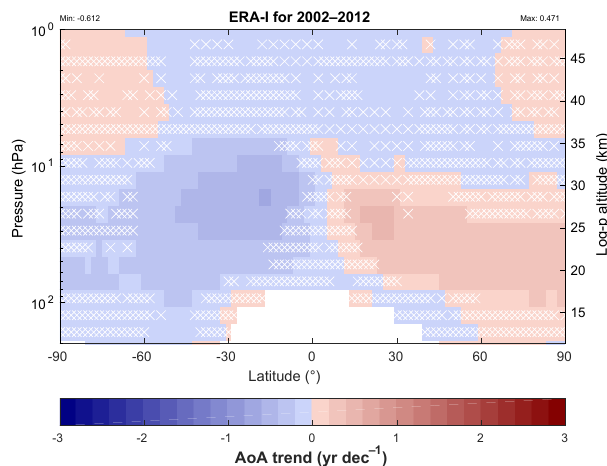
Figure 11. Latitude–pressure distribution of AoA trends (in years per decade) using the ERA-Interim reanalysis over 2002–2012. White crosses indicate grid points where the sign of the trend is not significant; i.e., its absolute value is smaller than the uncertainty delivered by the regression analysis at the 95% confidence level. The color scale is the same as in Haenel et al. (2015, Figs. 6 and 10) with darker blues indicating more negative trends and darker reds more positive